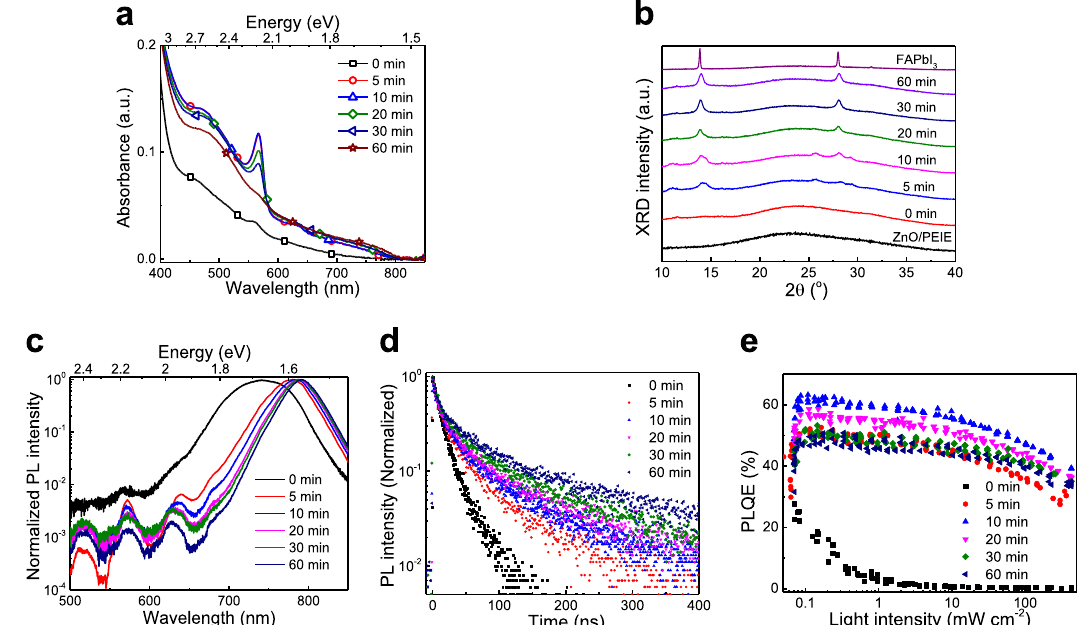
Fig. 2 Perovskite MQW fi lms deposited on PEIE modi fi ed ZnO layers. a Absorption spectra of NFPI 7 fi lms upon various annealing time. b XRD data of FAPbI 3 , ZnO/PEIE, and NFPI 7 fi lms upon various annealing time. c PL spectra of NFPI 7 fi lms excited by a 445 nm laser. d Time-resolved photoluminance of